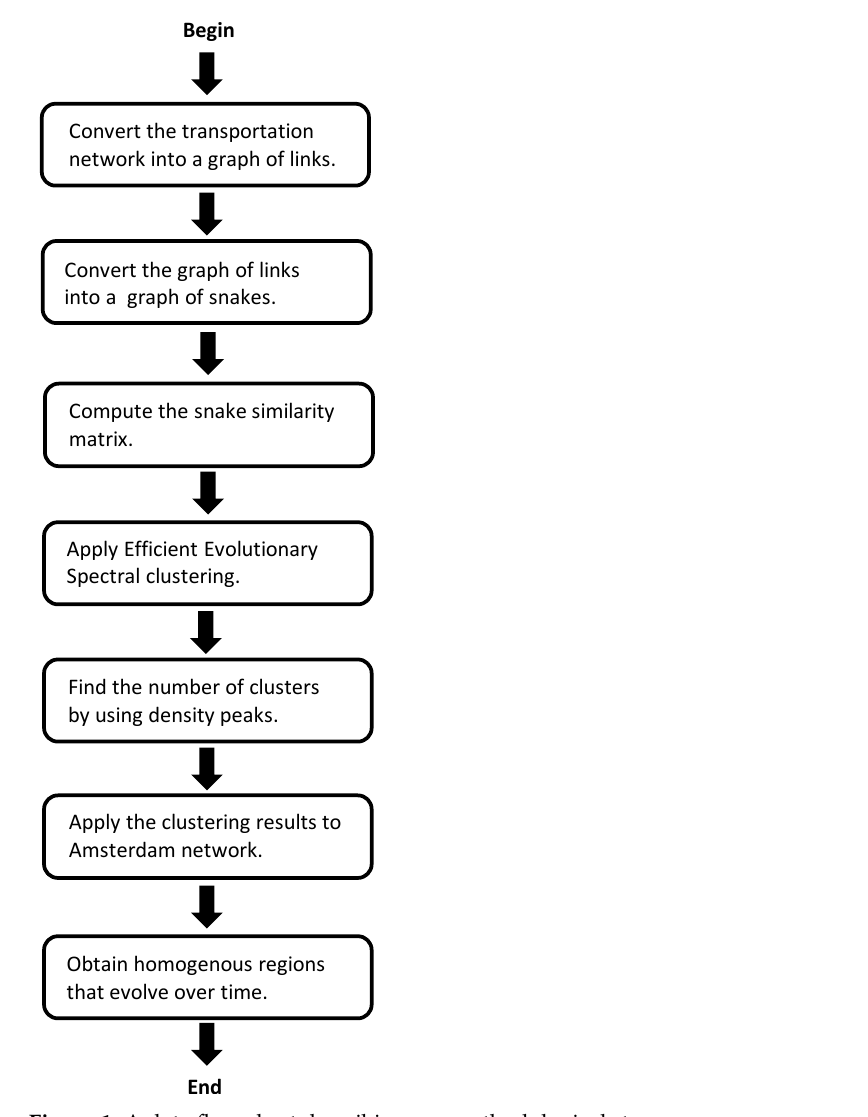
Figure 1. A data flow chart describing our methodological